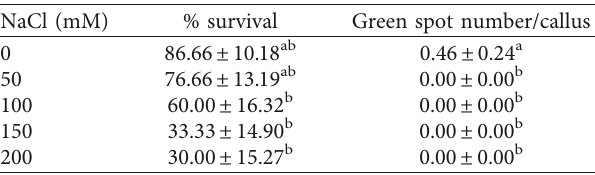
Table 3: Survival percentage and green spot quantity of salinity- treated calli after four